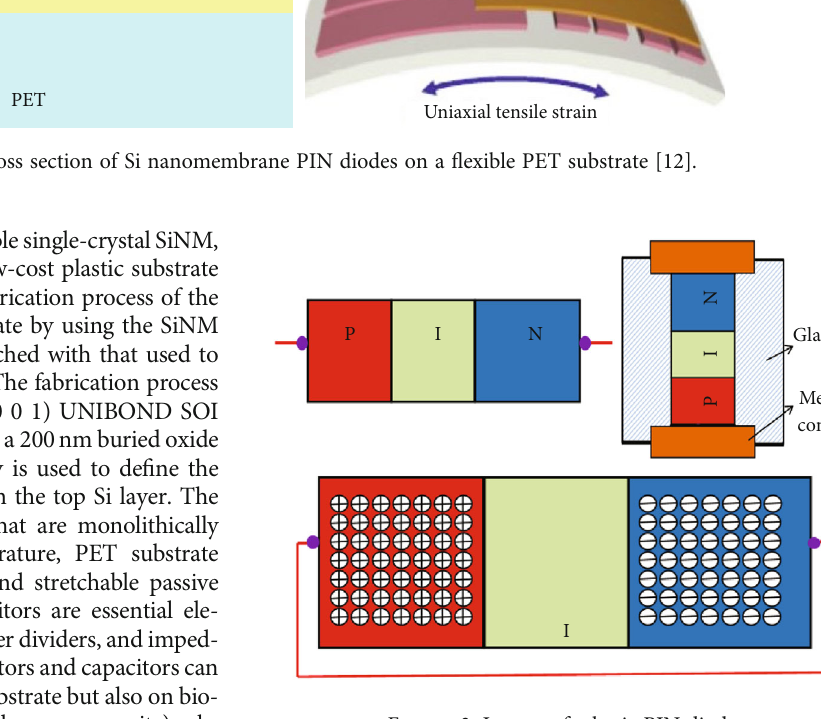
Figure 3: Layout of a basic PIN